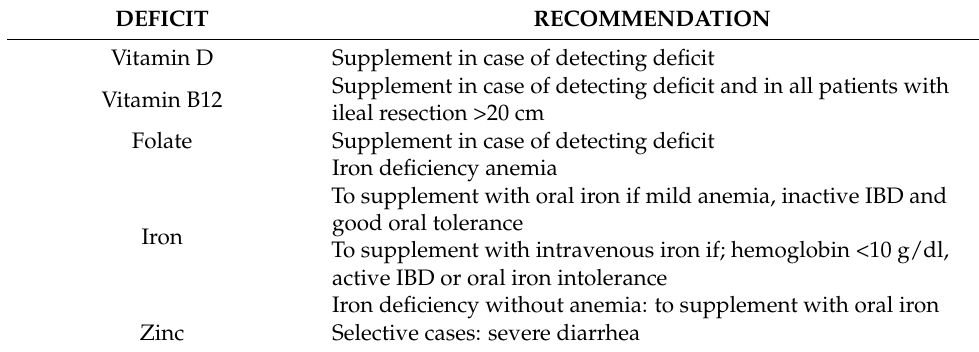
Table 3. Micronutrient deficiencies and supplementation